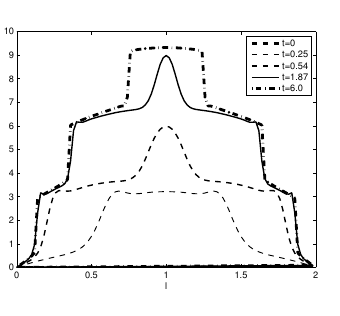
Figure 10. β ( l,t i ) with 3 jump in dependence on l for ωτ = 0 ⇒ 12, t f = 6.